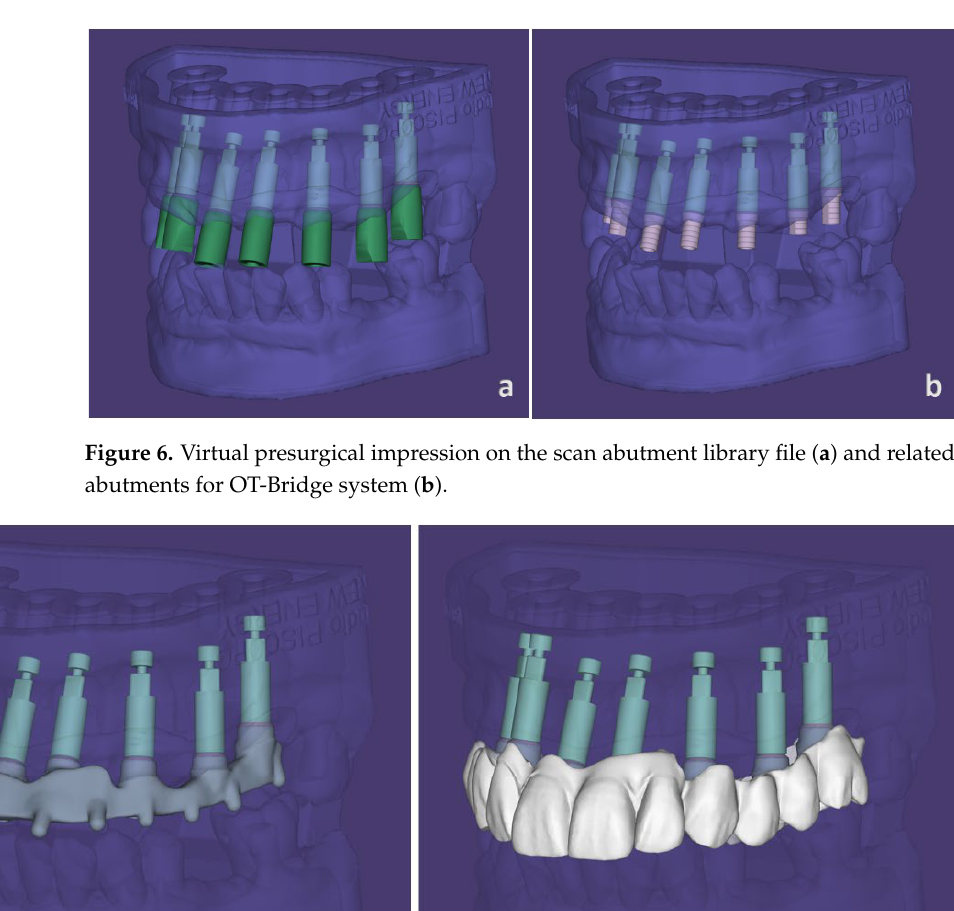
5 Figure 5. Virtual implant planning with OT-Equator attachments ( a ) and scan abutment library files ( b ). Lab workflow: 1.